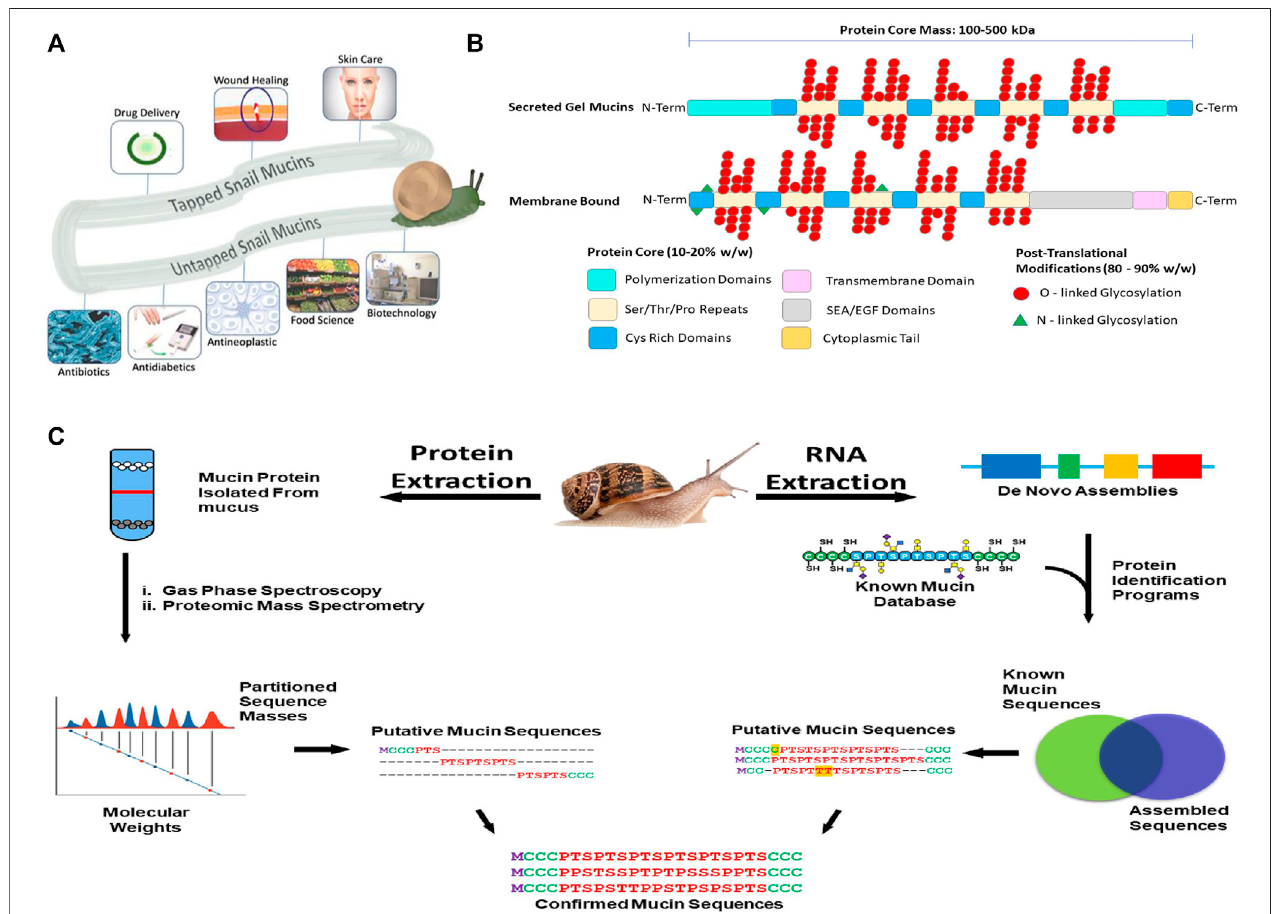
FIGURE 1 | (A) Applications of snail mucus. Snail mucus has been used for skin care, wound healing and rejuvenation, and drug delivery. Snail mucus is being explored in food science, implant coatings, and other biotechnical sectors are currently researching mucins to be explored for potential use. (B) A 2-dimensional representation of the mucin structures. Mucins are characterized by two parts of their structure, their protein core, and their glycan branching. The protein core is a proteinsequenceofvariablelengthdependingonthemucingene,whichhasbeenfurthermodi fi edwithglycosylationbranches.TheProteinstructure,howeverhas multipledomains,andthesedomainsvarydependingonthefunctionandthecellularlocationofthemucin.Theglycanbranchesaresugarbranchesrangingfrom3to18 sugars, and make up the majority of the mucin mass. Shown are 2 dimensional representations of the different types of mucins, and their stereotypical features. (C) Applying an integrated omics approach to identify snail mucin sequence, structure, and function. Path 1(left) extract crude mucin proteins and separate from the cellular debris to obtain sequence masses from spectroscopic and mass spectrometric analyses. Path 2(right) RNA extraction from mucus glands or whole animal followed by denovo assemblyofmucingenesequencestogenerateadatabasetoBLASTagainstbyacomparisonofassembledsequencestoaknownmucindatabase,weobtain putative mucin sequences. Combining the proteomic and RNA pipelines we con fi rm the native type mucin sequence for further analysis.